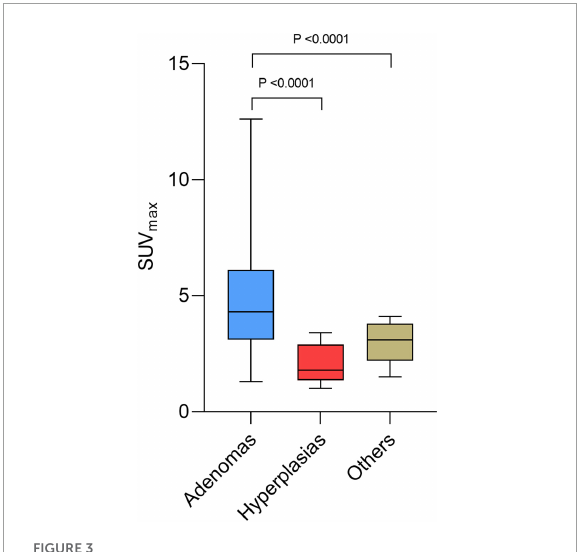
FIGURE3 Box plots of maximum standardized uptake value (SUV max ) for adenoma, hyperplasia, and other diagnosis.